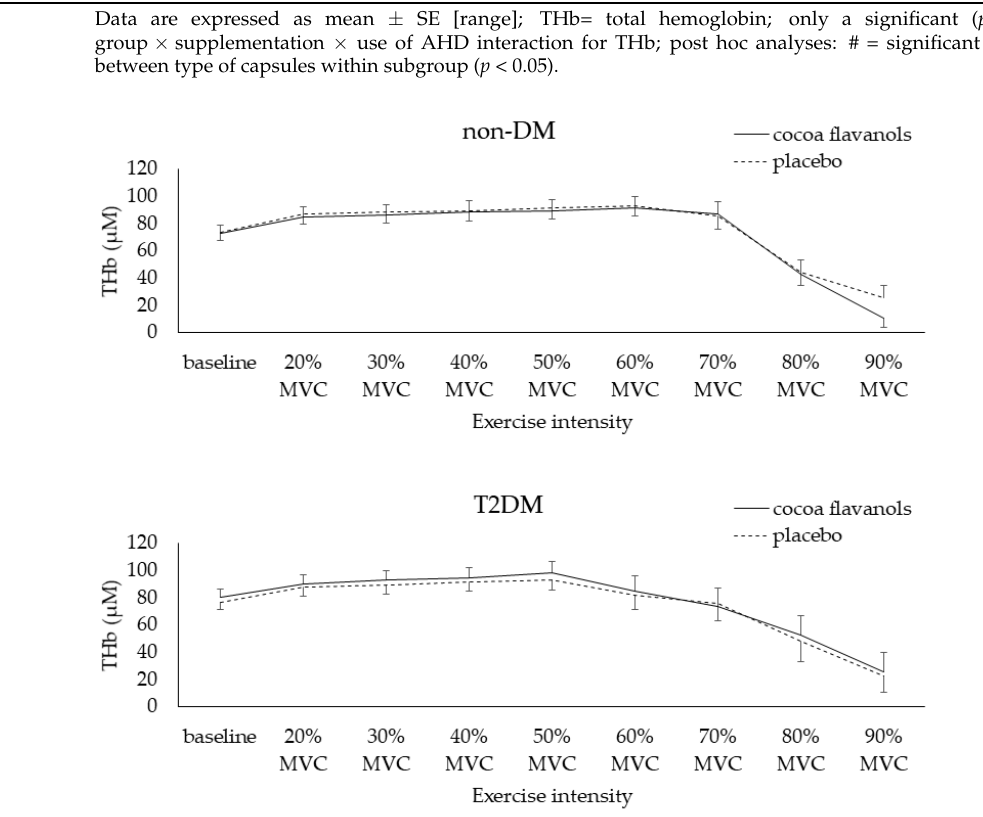
Figure 4. Muscle microvascular reactivity to the dynamic exercise test in both groups. Legend: data are means ± SE. MVC = maximal voluntary contraction; THb = total hemoglobin. Table 4. Results of examinations for macrovascular beds.